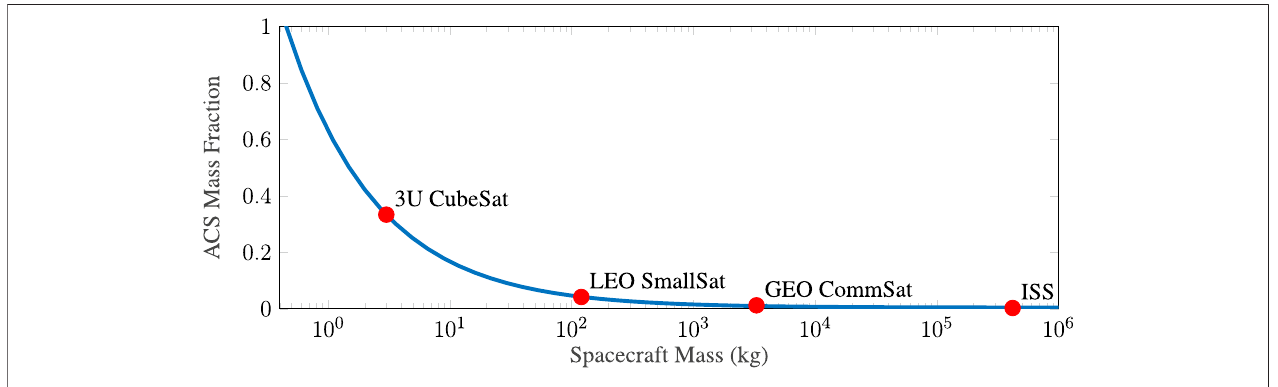
FIGURE 1 | Approximate mass fraction consumed by momentum actuators as a function of spacecraft